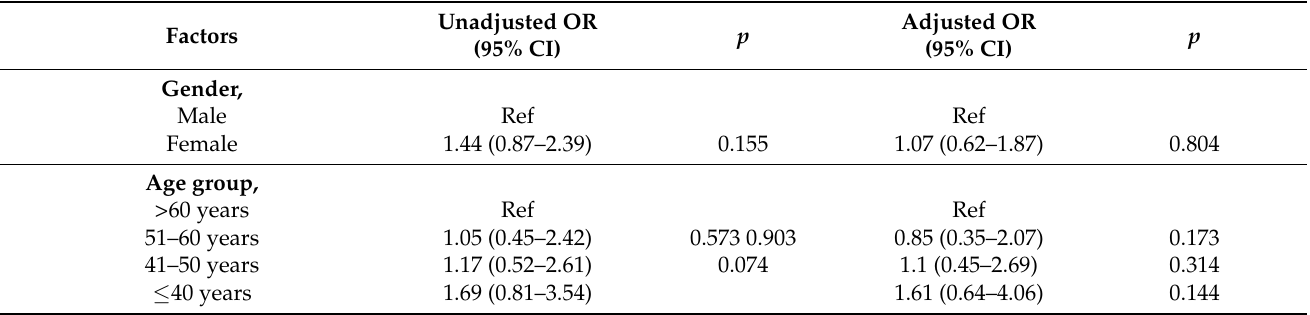
Table 3. Binary logistic regression analysis of non-adherence (ARMS total score <